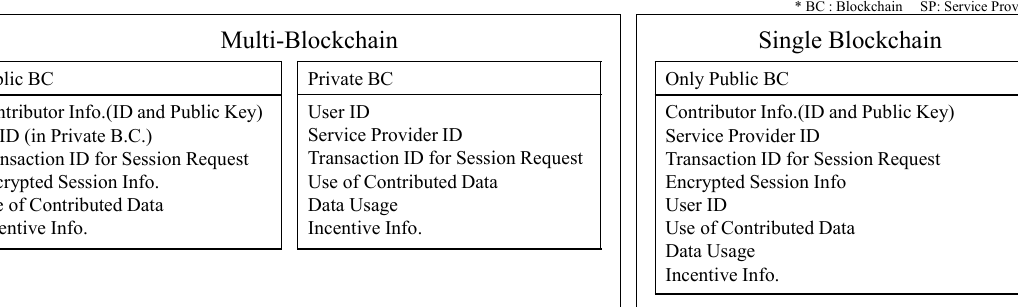
Figure 13. Comparison of block data structure in multi-blockchain and single blockchain.